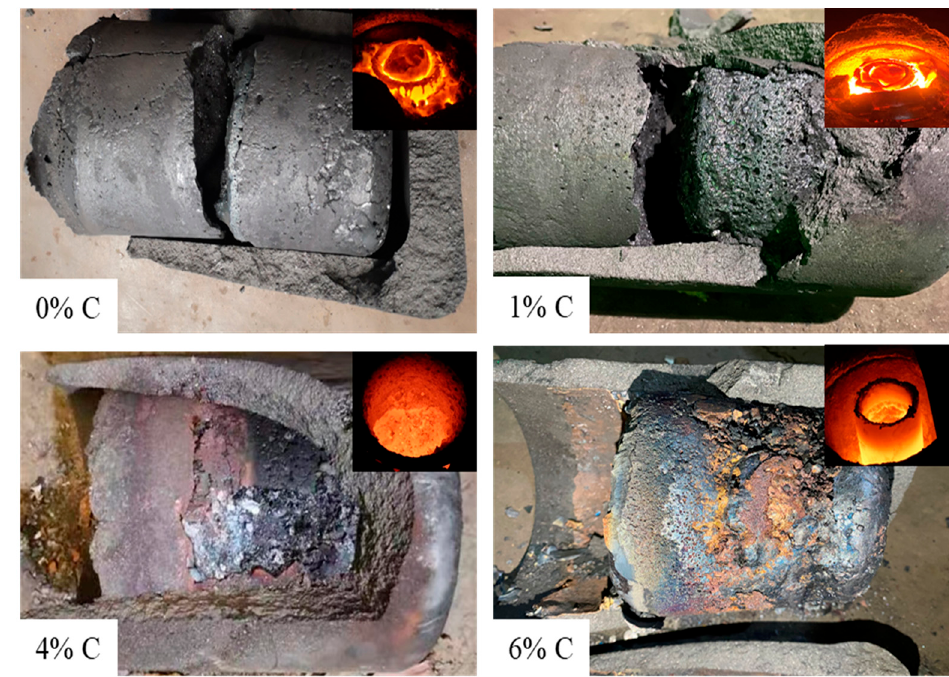
Figure 12. Physical schematic of the reduced samples and crucible.